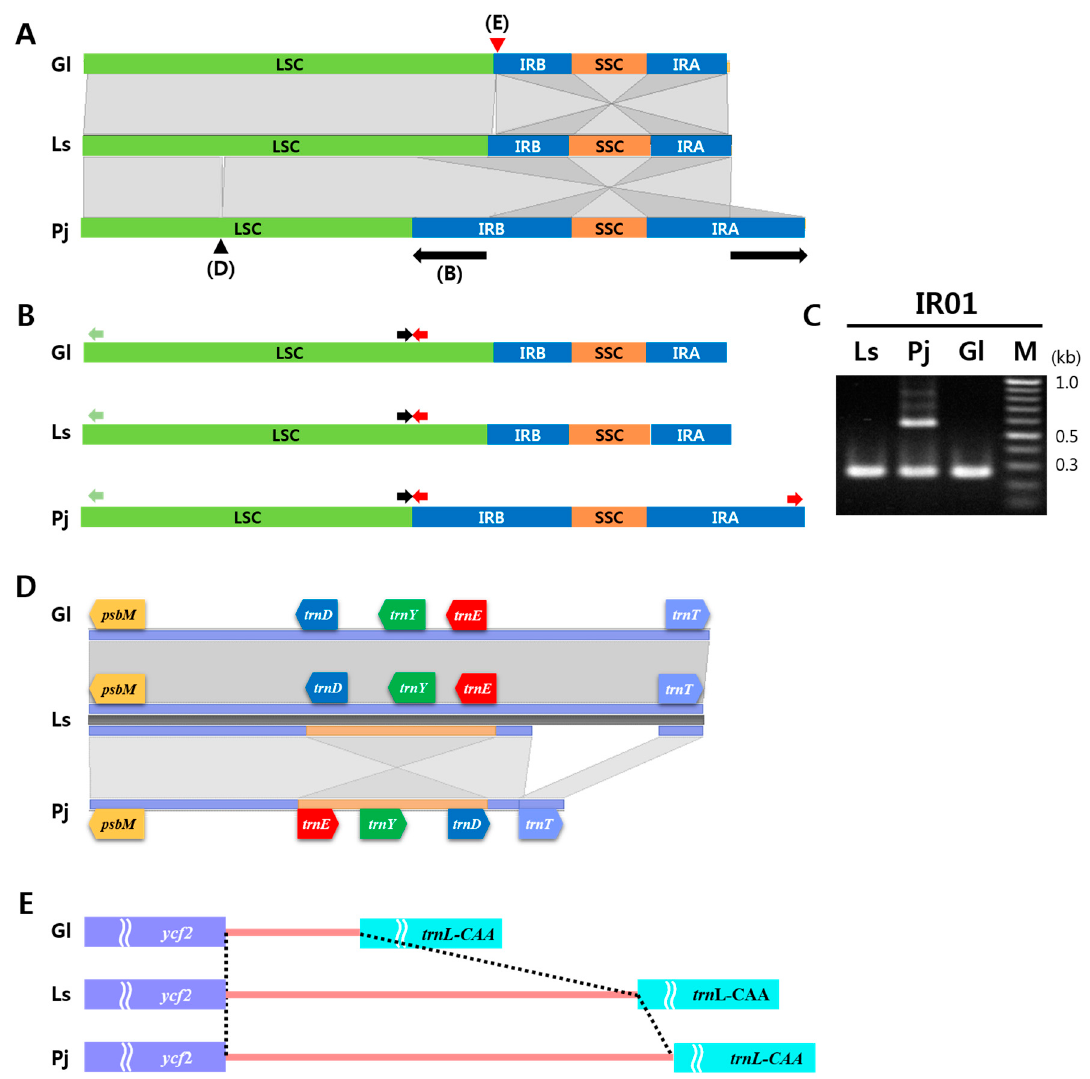
Figure 2. Comparative analysis of chloroplast (cp) genomes structure between the three Apiaceae species. ( A ) Blast-Z alignment of three species. Expanded inverted repeat (IR) regions (IRA and IRB) found in Peucedanum japonicum are indicated by arrows. ( B ) Locations of the three primers used to detect IR expansion in the cp genome sequences of three Apiaceae species. Black and red arrows indicate forward and reverse primers for control amplicons amplified in all three species, while the green arrows indicate primers specific to the left proximal junction region of the large single copy (LSC). Note that the site for the control reverse primer (red) is also present in the IRA region of the P. japonicum cp genome, resulting in amplification of one additional DNA fragments. ( C ) PCR results to validate the IR junction. A DNA fragment of about 0.6 kb in length was only amplified in P. japonicum , while a DNA fragment of about 0.3 kb amplified by control primers was detected in all three Apiaceae species. PCR amplicons were analyzed by 1.3% agarose gel electrophoresis. ( D ) Gene inversion found in P. japonicum . A 625-bp region, including trn D-GUC, trn Y-GUA, and trn E-UUC, was inverted in P. japonicum (indicated by black arrowhead in A), unlike in Glehnia littoralis and Ledebouriella seseloides . ( E ) Variable intergenic region between the three species. The ycf 2 ~ trn L-CAA intergenic region (indicated by red arrowhead in A) in G. littoralis (391 bp) was much shorter than those in L. seseloides (1,201 bp) and P. japonicum (1,306 bp). Ls, L. seseloides ; Pj, P. japonicum ; Gl, G. littoralis .